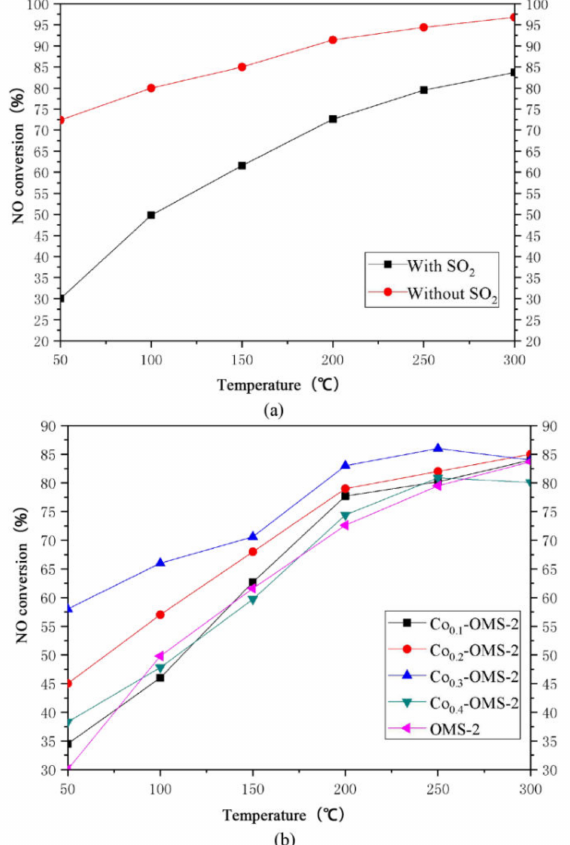
Figure 12. ( a ) NO conversion curve of oms-2 in the presence and absence of SO 2 respectively, ( b ) The NO conversion curves of modified oms-2 in the presence of sulfur dioxide